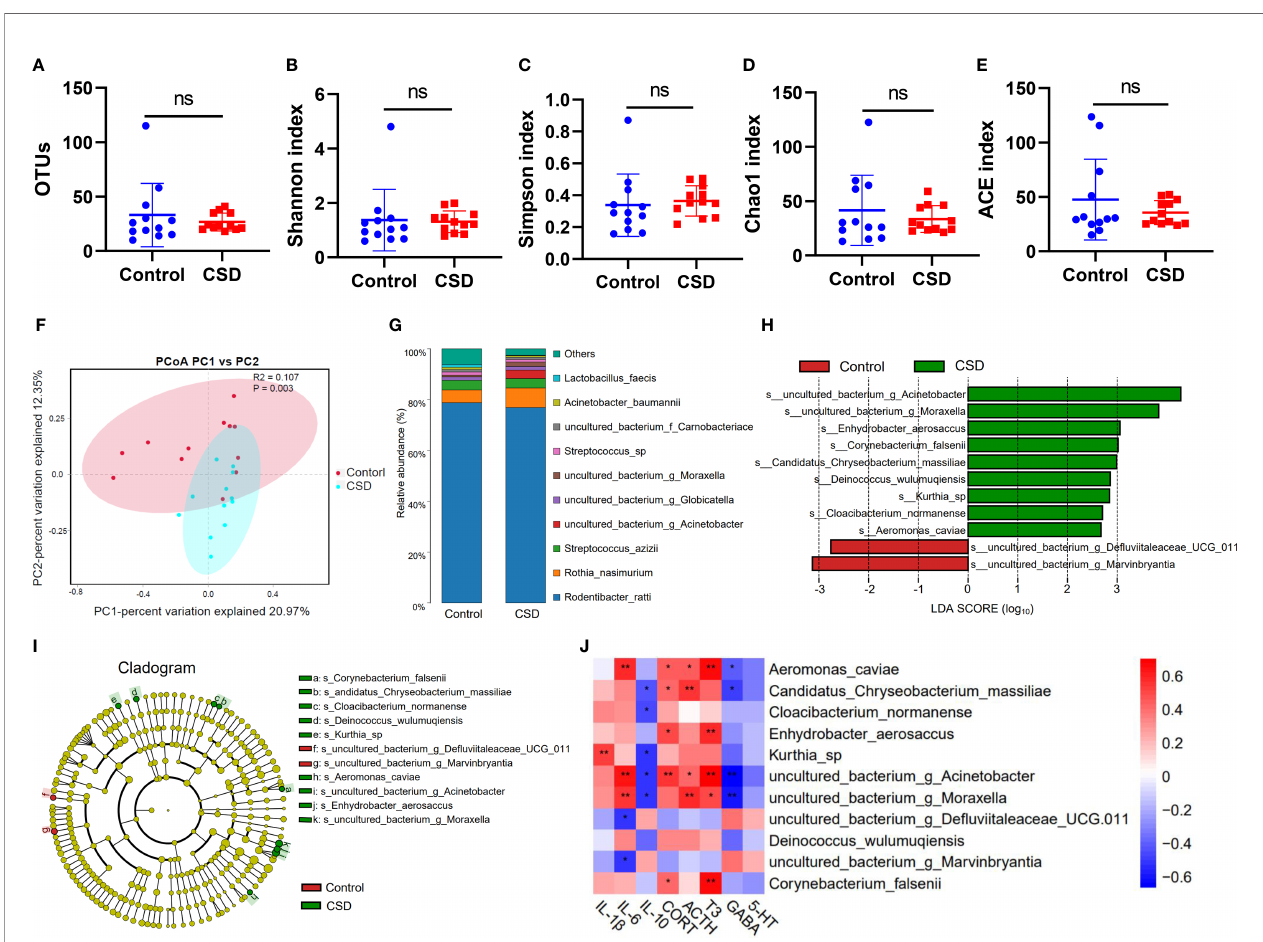
FIGURE 4 | Impact of CSD intervention on oral microbiota. Responses of the alpha diversity of the oral microbiota to CSD in rats including (A) OTUs, (B) Shannon index, (C) Simpson index, (D) Chao1 index, and (E) ACE index of each group (n = 12, using unpaired Student ’ s t test; ns, no signi fi cance) (F) PCoA plots explaining 21% and 12% of the variance of OTUs adjusted for abundance of the control and CSD groups (PERMANOVA test). (G) Oral microbiota composition. (H) LDA scores of differentially abundant taxa between the control and CSD groups using the LEfSe method. (I) Taxonomic cladogram generated from the LEfSe analysis. (J) Spearman correlation analysis between differential abundance bacteria and changed biochemical indexes. (*P < 0.05; **P <